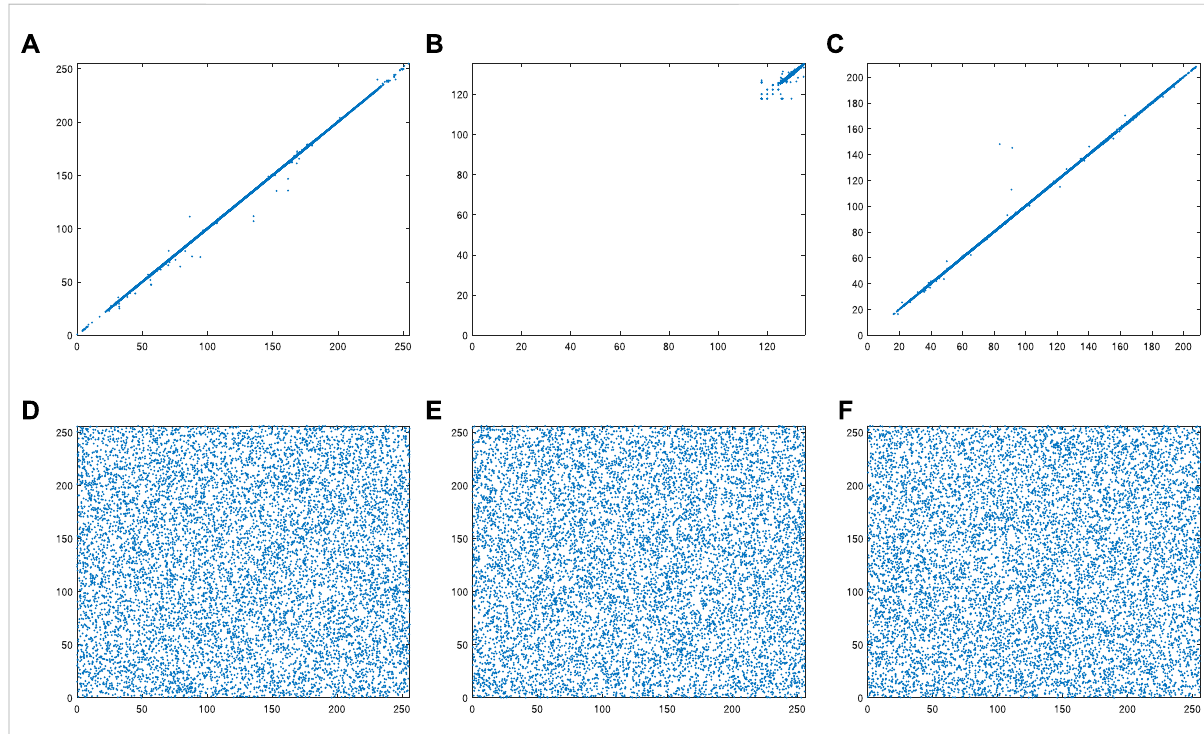
FIGURE 12 Correlation analysis of Topographic map of Colombia. (A) X-direction of plaintext. (B) Y-direction of plaintext. (C) Z-direction of plaintext. (D) X-direction of ciphertext. (E) Y-direction of ciphertext. (F) Z-direction of